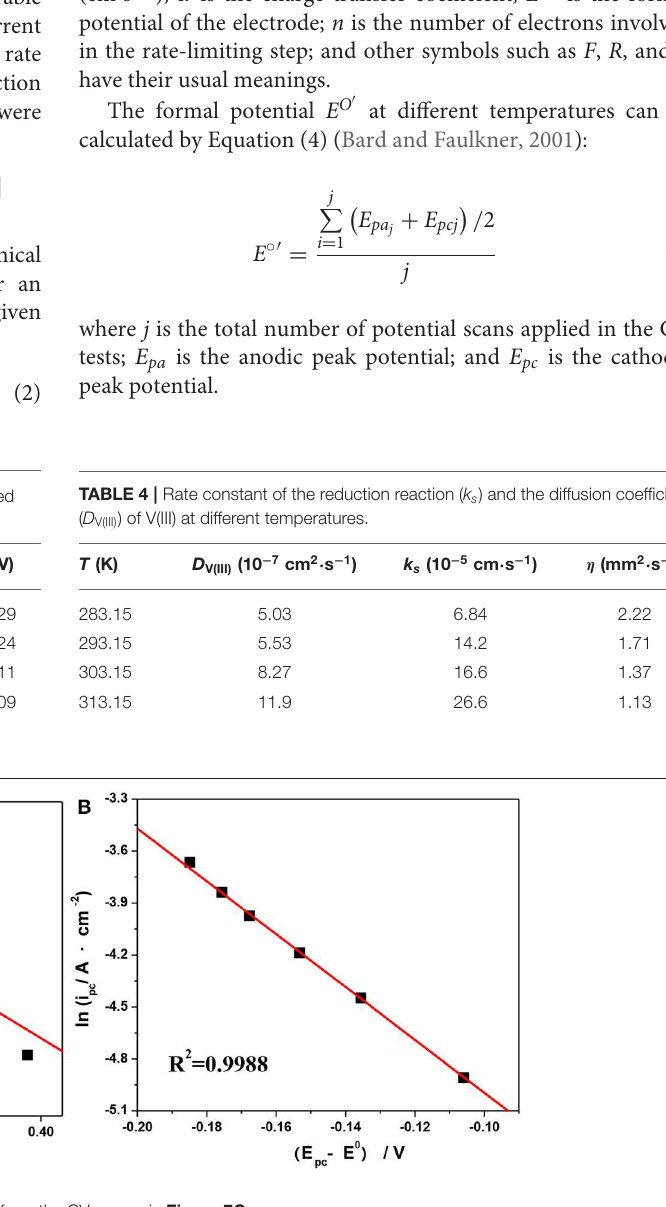
FIGURE 8 | Plots of i pc vs. V 1 / 2 (A) and ln i pa vs. ( E pc –E O ′ ) (B) at 303.15K from the CV curves in Figure 7C .